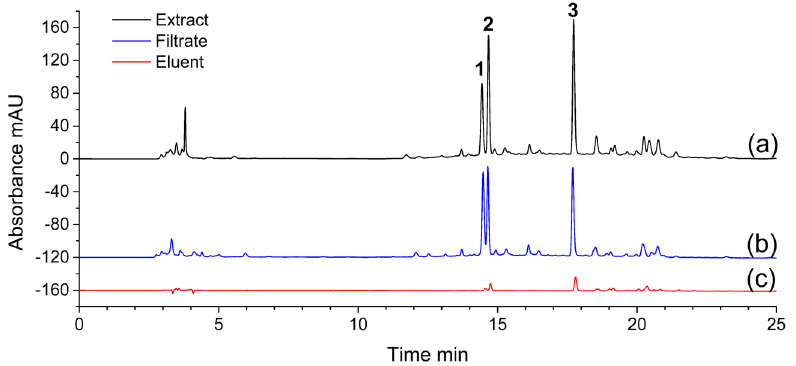
Figure 1: The chromatograms of ( a ) jute leaves extract, ( b ) fi ltrate, and ( c ) eluent after ultra fi